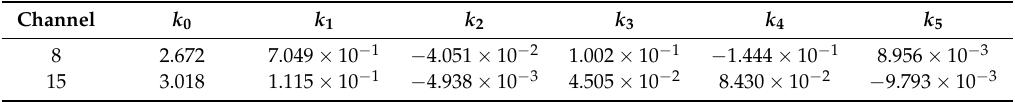
Table 4. Settings of the radiative transfer model for calculating OLR Parameter Values N Spectral Band ( µ m) Tropical, Mid-Latitude Summer & Winter, Atmospheric Profile COT Cloud Height (km) 0, 2, 4, 6, 8, 10, 12, 14, 16 Temperature, H 2 O, CO 2 , O 3 , etc. Default